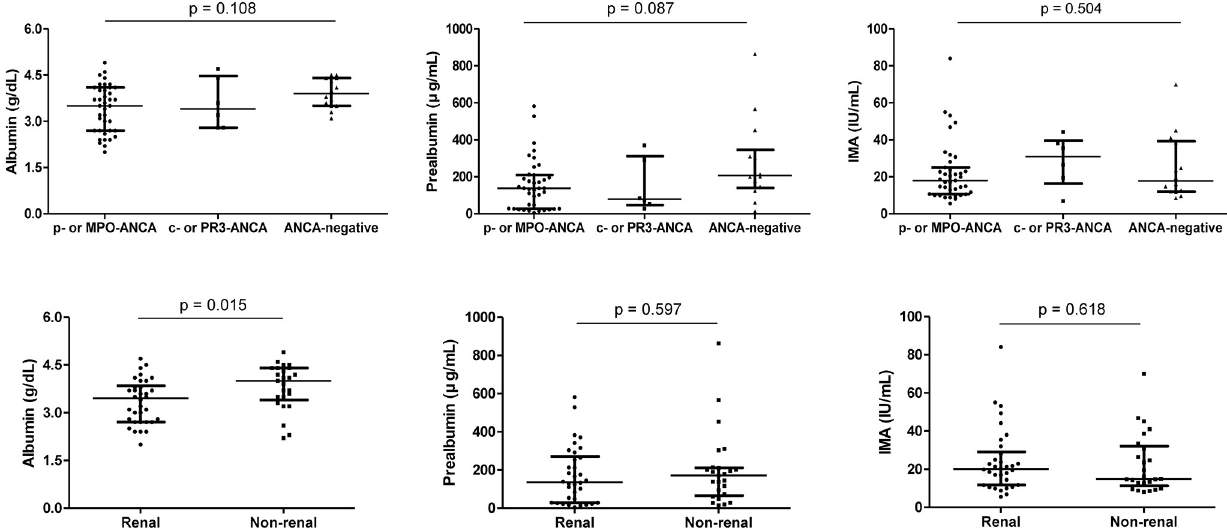
Fig 3. Baseline albumin, prealbumin, and ischemia-modified albumin levels based on ANCA serology and renal involvement. ANCA serology did not significantly affect levels of albumin, prealbumin, and ischemia-modified albumin. Meanwhile, albumin level was significantly lower in patients with renal involvement that in those without. The error bars present median and interquartile range. ANCA: anti-neutrophil cytoplasmic antibody; P: perinuclear; MPO: myeloperoxidase; C: cytoplasmic; PR3: proteinase 3; IMA: ischemia-modified